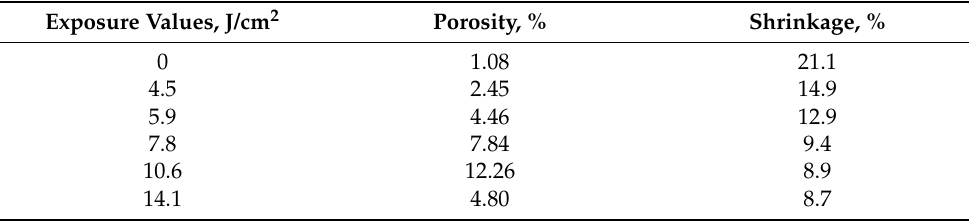
Table 2. The value of porosity according to SEM data for the NiO/YSZ anode sintered at different laser exposures.